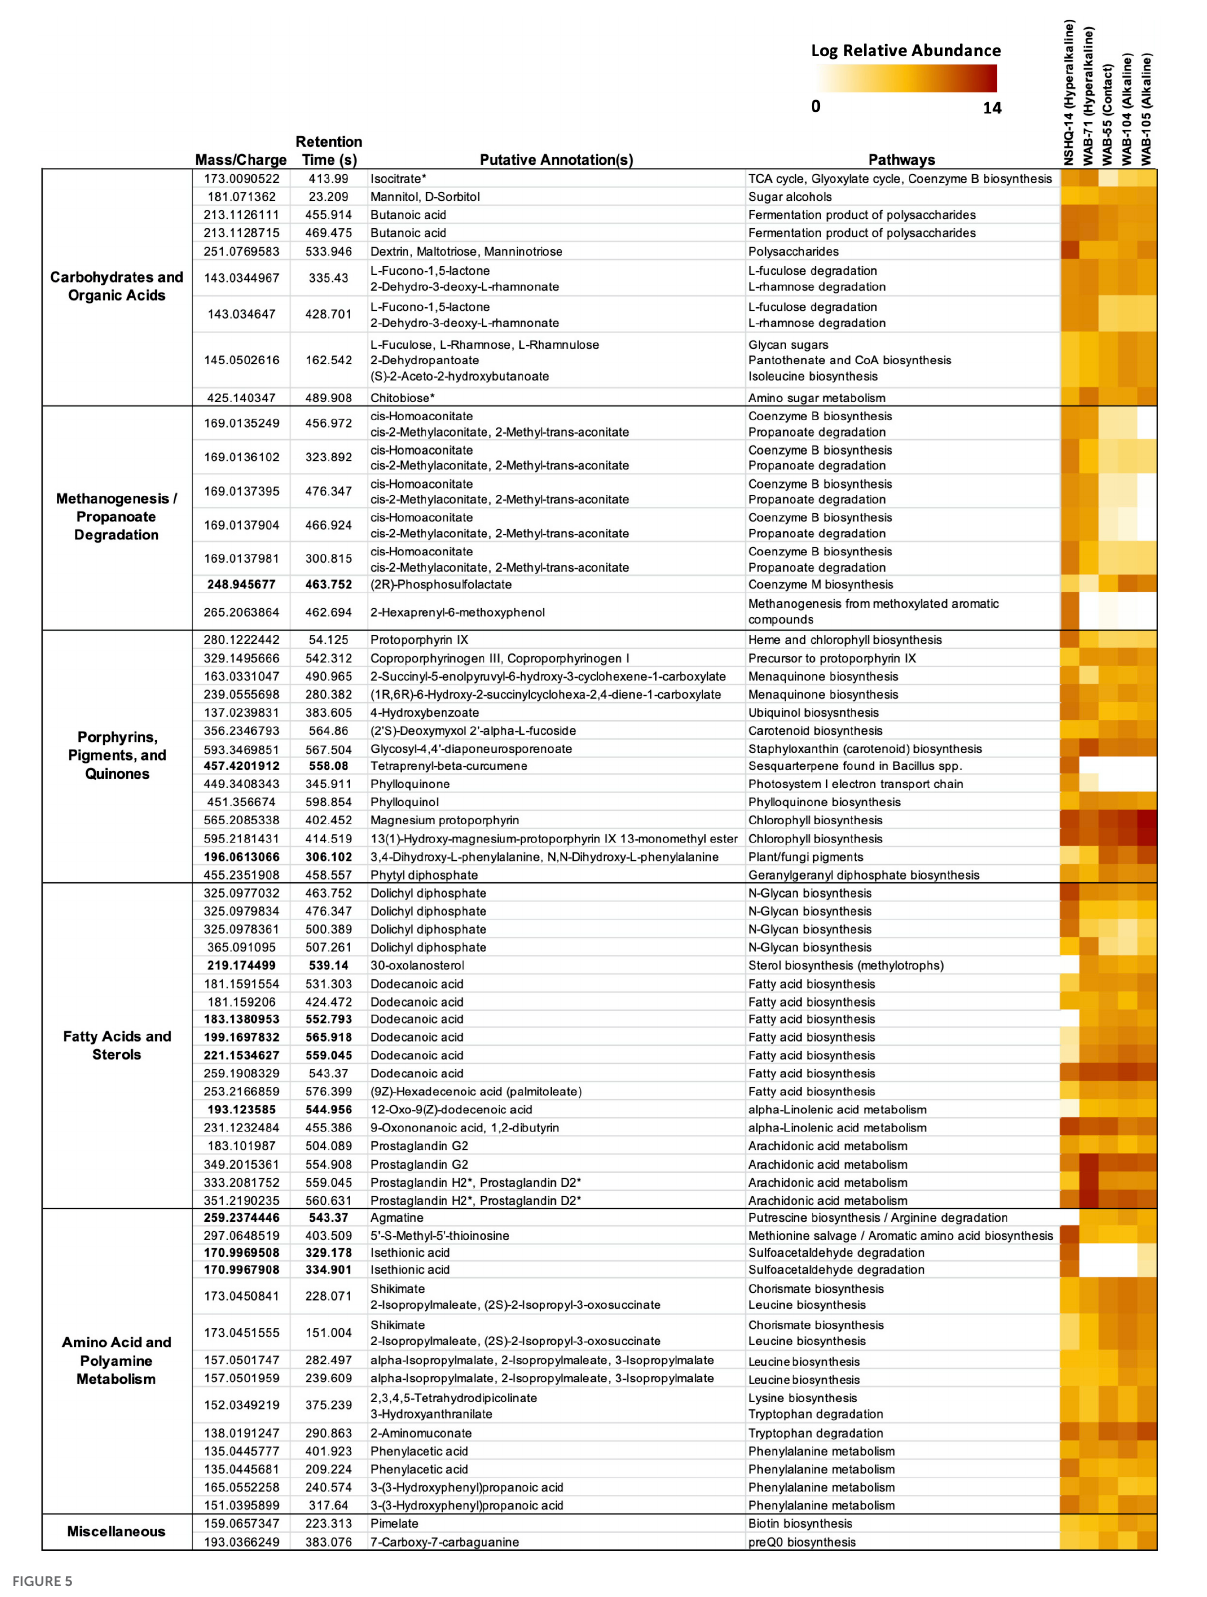
FIGURE5 Features cross-referenced between KEGG results and mummichog annotations. Features are grouped by putative annotation/function. Diagnostic features appear in bold. Feature annotations confirmed by MISA are indicated with an asterisk (*). Feature abundance is expressed as the log of the normalized relative